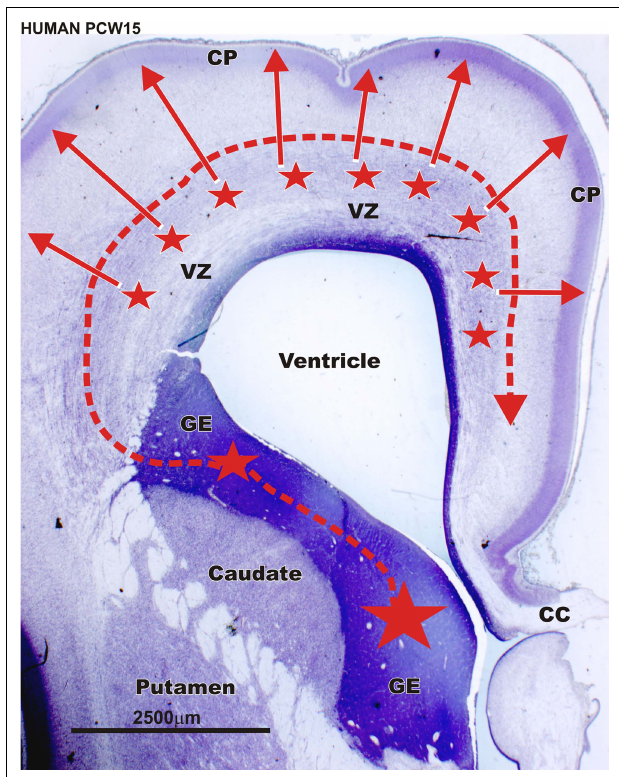
FIGURE 7 | Sources of cortical GABAergic neuron in the the primate during middle fetal stage. Nissl staining of frontal brain sections through rostral part of the telencephalic vesicle in a human fetus at postconceptional week (PCW) 15 (at a level of the anterior horn). In human (PCW15 – PCW20) as in macaque monkey [embryonic day (E) 64 to E75] later during gestation, GABAergic neurons are produced massively by the proliferative zones of the dorsal telencephalon (smaller stars – full red arrows). According to Letinic et al. (2002) these dorsal proliferatives zones generate 65% of the cortical GABAergic neurons. This massive dorsal production of GABAergic neurons is primate-specifi c. VZ – ventricular and subventricular zone; CP – cortical plate; CC – corpus callosum. Scale bar: 2500